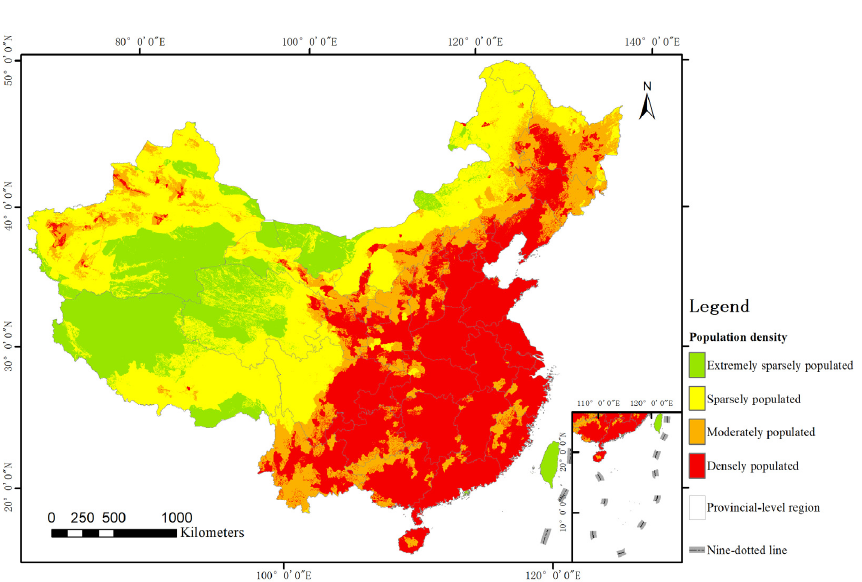
Figure 7. Distribution of classified population density in China’s mainland.